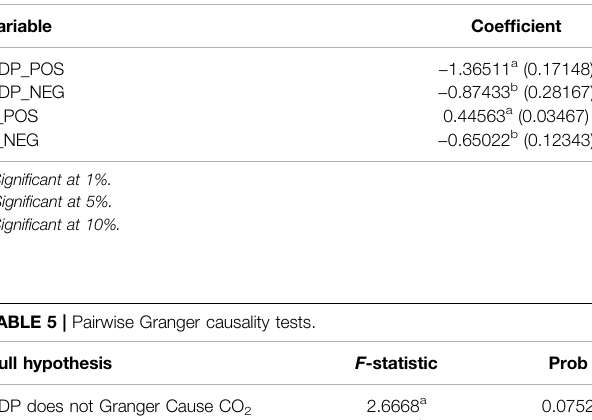
TABLE 2 | Bound test.